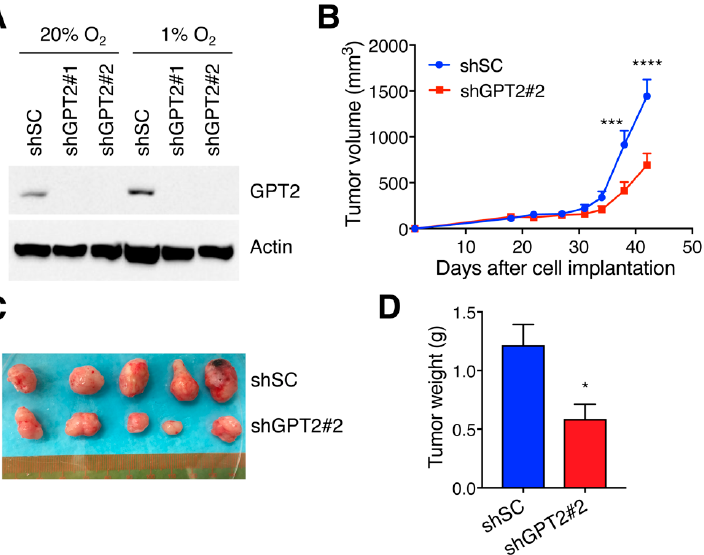
Figure 6. GPT2 promotes GBM tumor growth in mice. ( A ) Immunoblot analysis of indicated proteins in SC and GPT2 knockdown U87MG cells exposed to 20% or 1% O 2 for 24 h. ( B – D ) Growth of SC and GPT2 knockdown U87MG tumors in mice. The tumor growth curve is shown in ( B ) (mean ± SEM, n = 5). *** p < 0.001, **** p < 0.0001 by two-way ANOVA with Sidak’s test. The tumor image is shown in ( C ). The tumor weight is shown in ( D ) (mean ± SEM, n = 5). * p < 0.05 by Student’s t test.